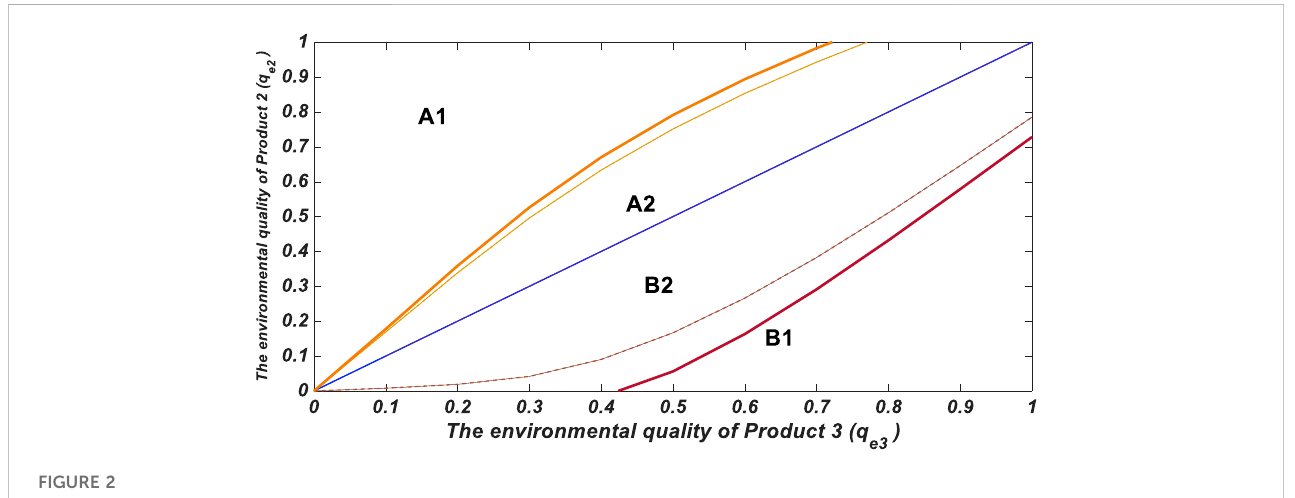
FIGURE 2 Optimal strategy for manufacturer 1 with